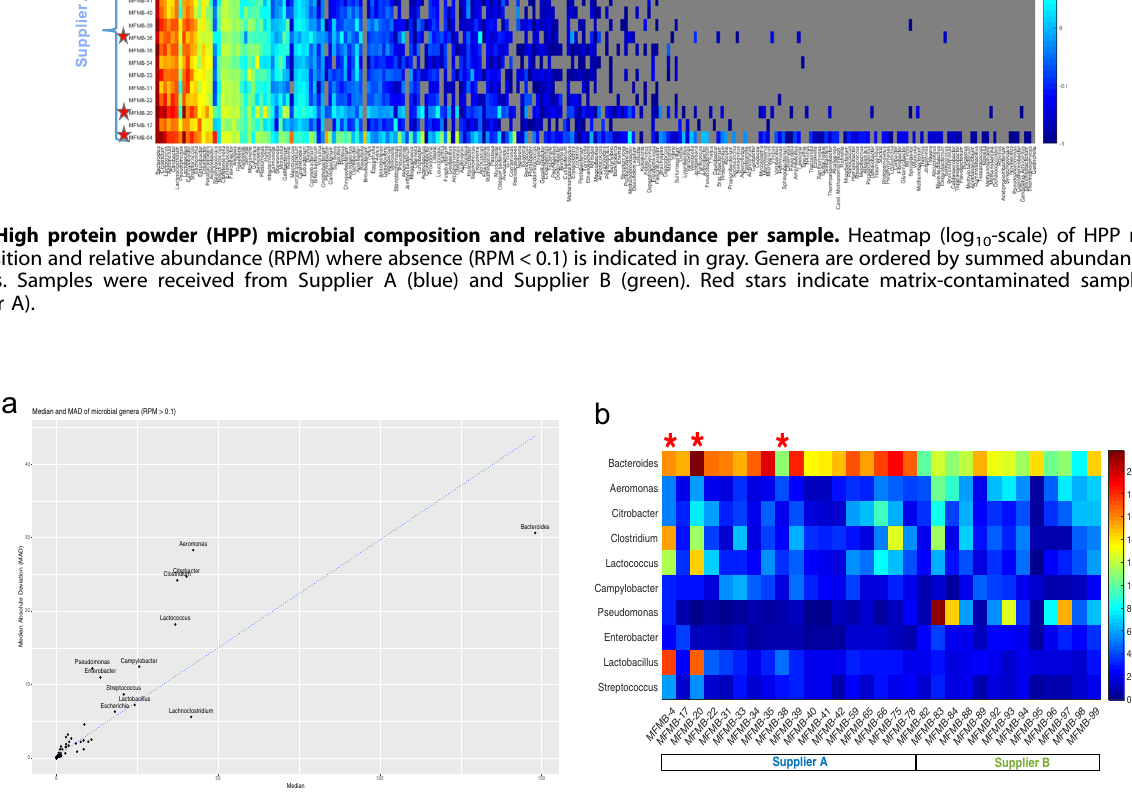
Fig. 5 Variability of microbial genera relative abundance. a All identi fi ed microbial general are plotted with median value and median absolute deviation (MAD) of RPM abundance. Genera with MAD > 5 are labeled with the genus name and a linear fi t is indicated by a blue dotted line. b Heatmap (log 10 -scale) of ten microbial genera with the largest median absolute deviation (MAD) across samples. Genera are ordered by decreasing MAD from top to bottom. Samples were received from Supplier A (blue) and Supplier B (green). Red stars indicate matrix-contaminated samples (from Supplier